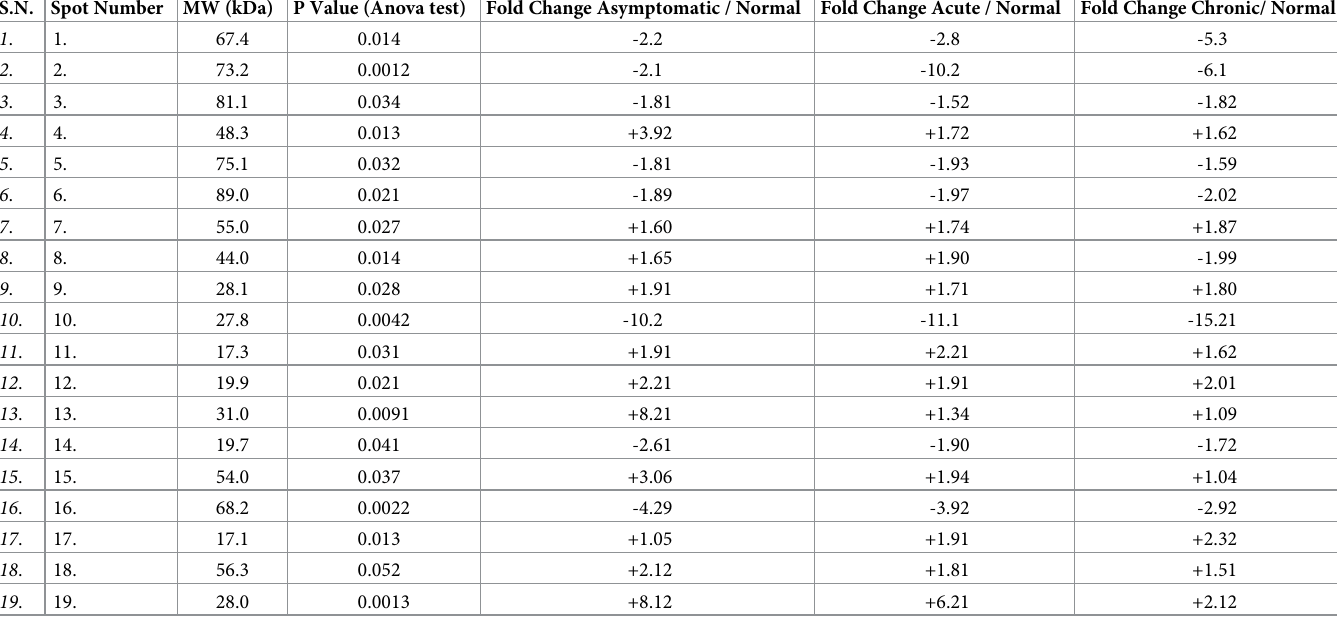
Plus sign indicates up-regulated whereas minus sign indicate down-regulated proteins in comparison to normal subjects.